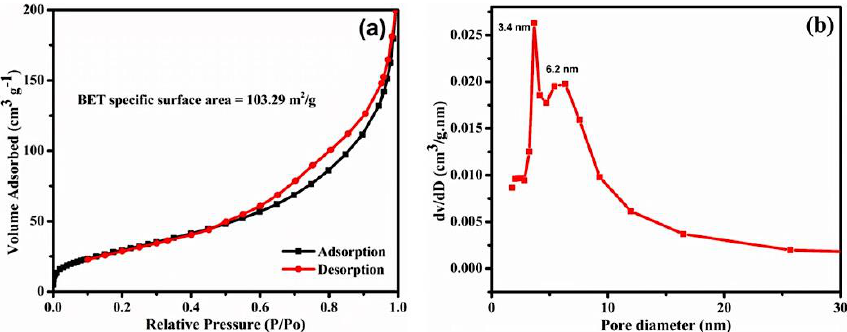
Figure 5. ( a ) Nitrogen adsorption-desorption isotherms and ( b ) PSD of Fe 3 O 4 /RGO composite. Electrochemical Properties